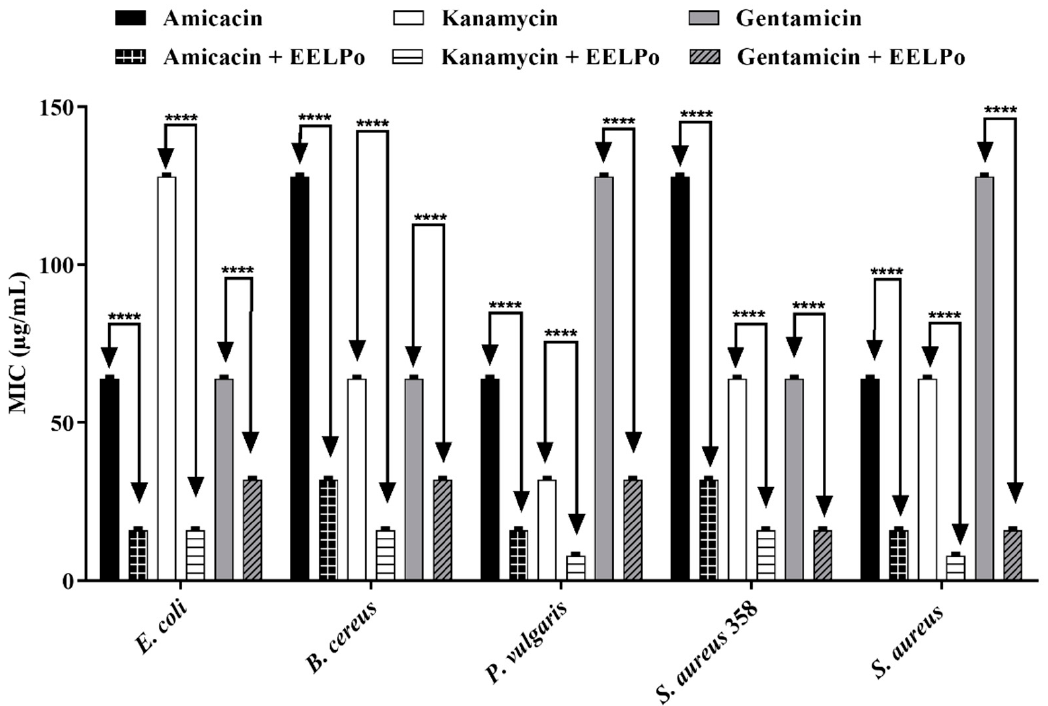
Figure 4. Modulating effect of P. ornatus fresh leaf ethanol extract on the antibiotic activity of amikacin, kanamycin and gentamicin against E. coli , B. cereus , P. vulgaris , S. aureus 358 and S. aureus strains. ****: p < 0.0001 (ANOVA and Tukey’s test).